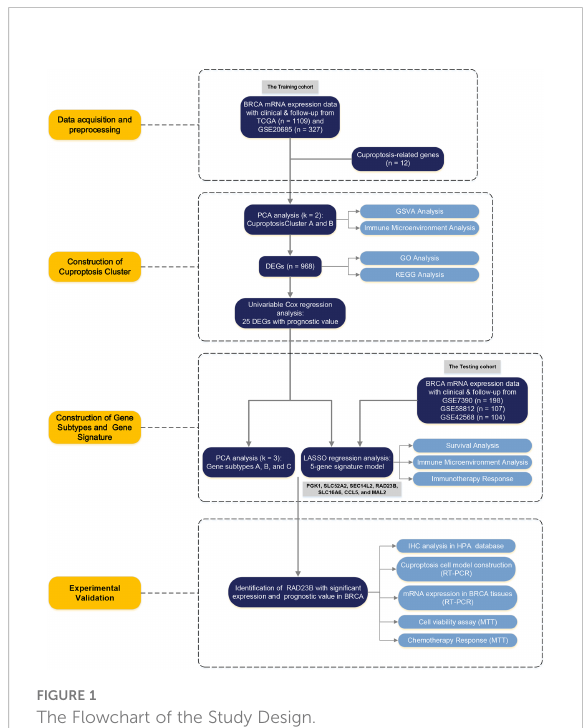
FIGURE 1 The Flowchart of the Study